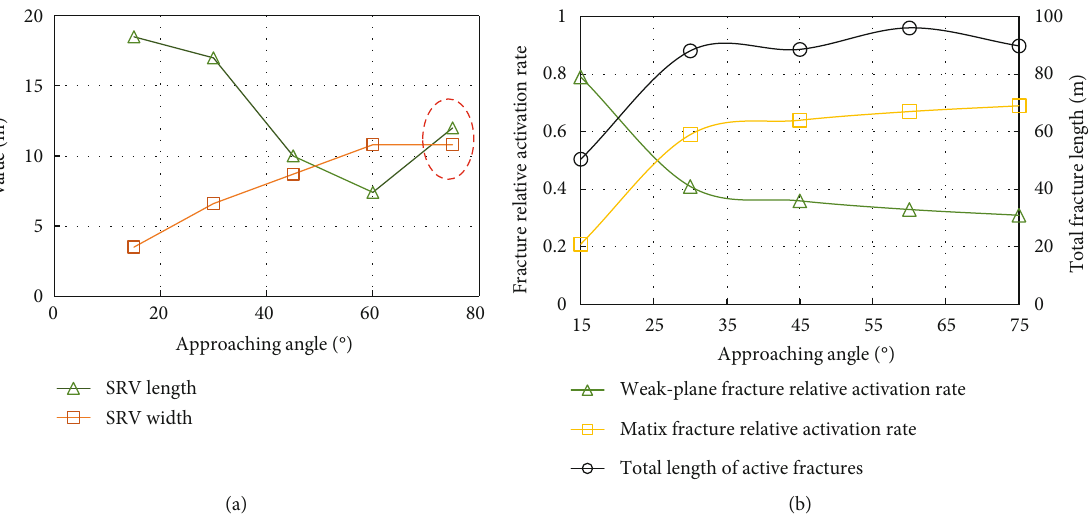
Figure 11: In fl uence of azimuth on SRV (a) and fracture relative activation (b).